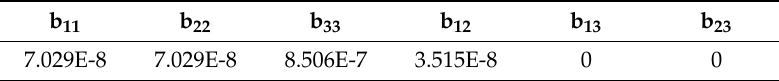
Table 2. Coefficients of the ellipsoid in simulating the preferred growth of Ni(OH) 2 (the ellipsoid is characterized by six coefficients).